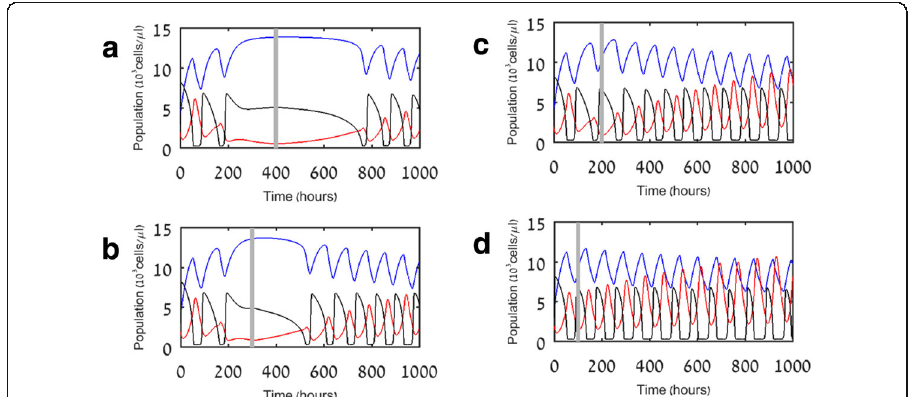
Fig. 5 Simulation results of model V2 for treatment with PD-1/PD-L1 checkpoint blockers at different time points during sepsis. Blue, red, and black lines indicate myeloid cells (M), lymphocytes (L), and pathogen (P), respectively. Vertical straight lines indicate the time at which immunotherapy is administered: a 400 h; b 300 h; c 200 h; d 100 h